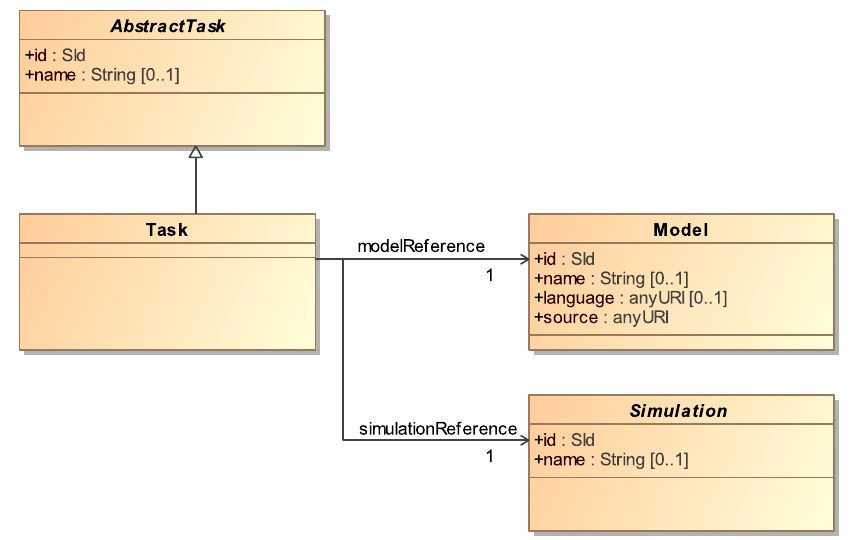
Figure 2.33: The SED-ML Task class